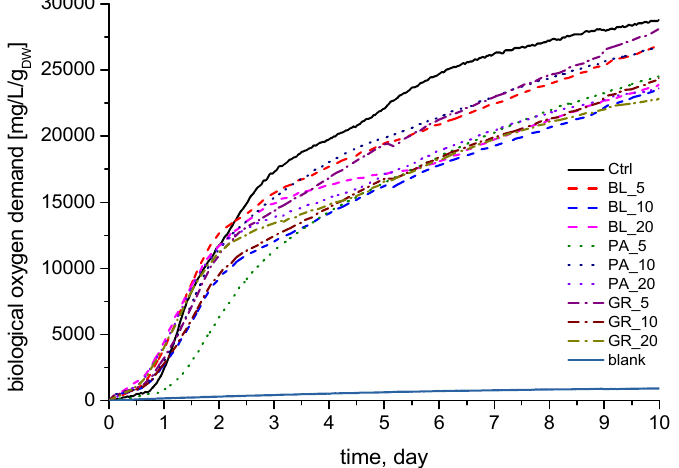
Figure 9. The course of respiratory activity of the tested biogas samples (the graph shows average values; n = 3).